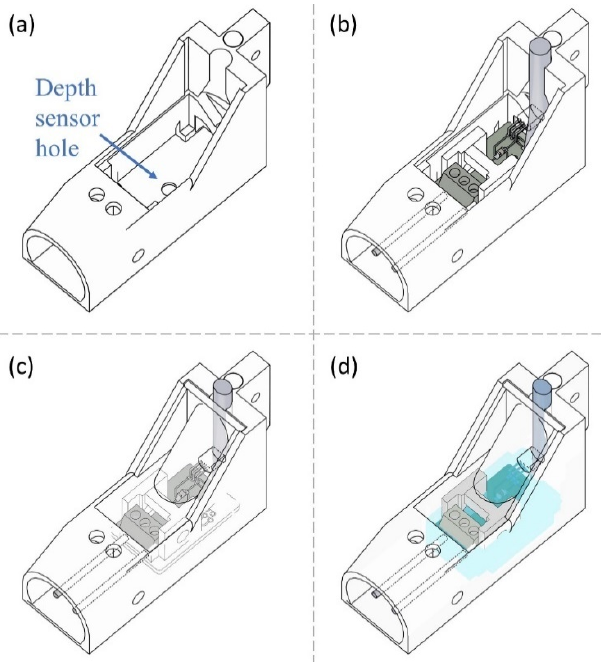
Figure A1. ( a ) The base on the designed 3D sensor covers for easy and quick installation in the field; ( b ) how the sensor board, EC pins, and the sensor holder are placed into the sensor case; ( c ) the sensor case lid to push the sensor board down and forms as physical protection of the sensor; and ( d ) injecting the potting compound gel for waterproofing purpose.